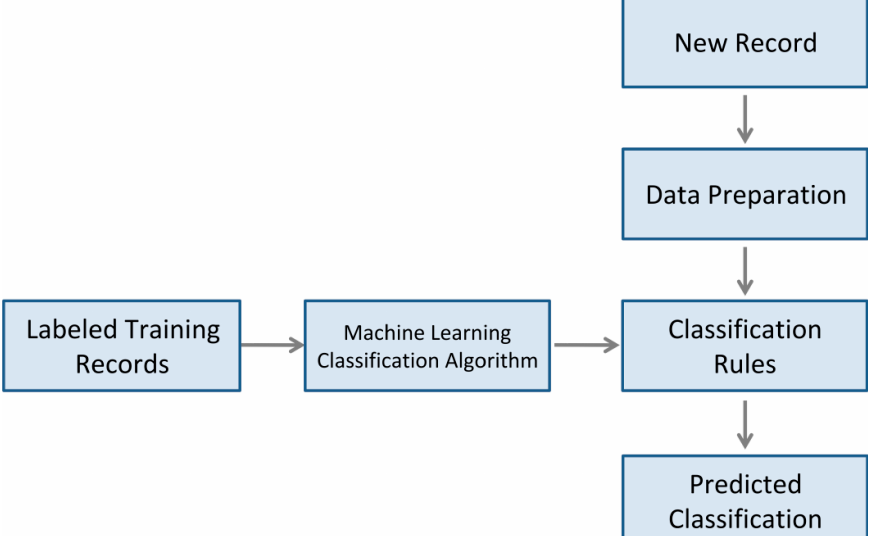
Figure 4. The stages of the machine learning